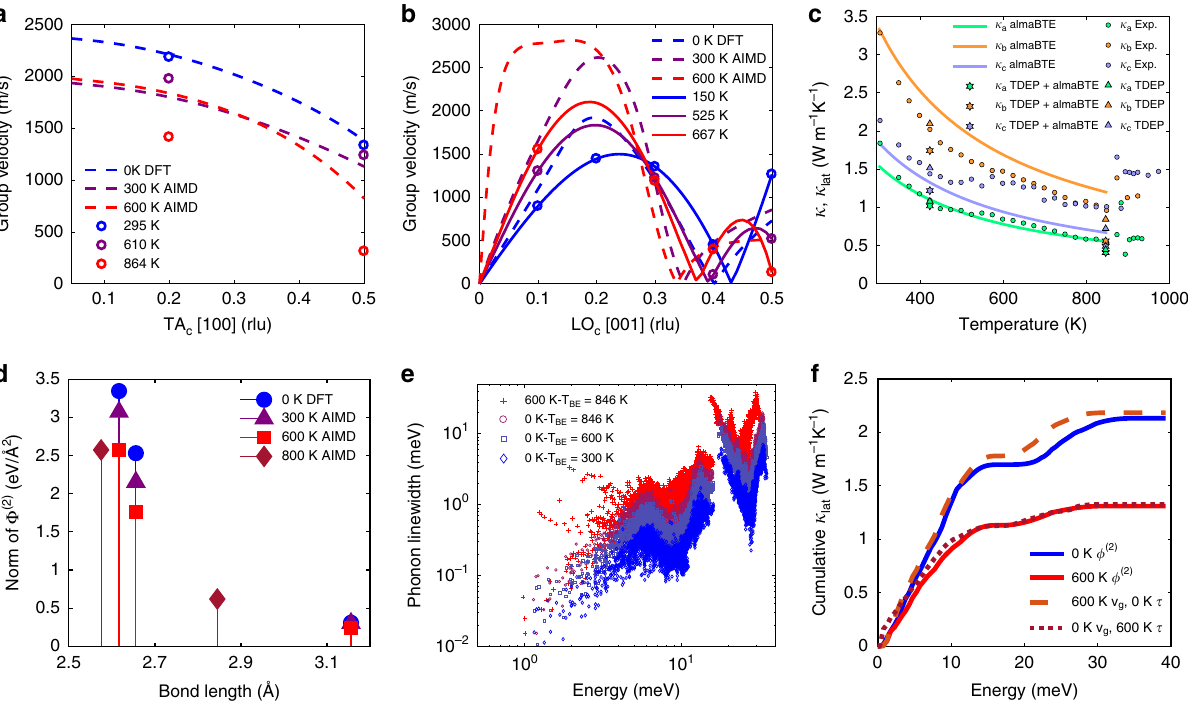
Fig. 4 Phonon renormalization and effect on thermal transport. a Group velocities extracted from experiments and simulations (see “ Methods ” for details) for the TA c along [100] (measured with CTAX at Q = (1.5, 0, 1) and (1.8,0,1)) and b LO c along [001]. Open circles show Q corresponding to experimental measurements, solid lines are for v g from experiments and dashed lines for v g from simulations. c Measured κ (circles) and calculated κ a , b , and c crystallographic directions. Lines represent κ lat (lines and markers) along the lat computed with almaBTE and triangles are values from TDEP, while stars are from almaBTE, but with renormalized Φ (2) from TDEP. d Norm of Φ (2) from DFT (0 K) and TDEP (Pnma at 300, 600 K and Cmcm at 800 K). e Phonon linewidths calculated with Φ (2) from 0 K DFT ( T BE = 300, 600 and 846 K) and 600 K TDEP ( T BE = 846 K) with fi xed Φ (3) (almaBTE). f Cumulative κ lat ( T BE = 300 K) from RTA with Φ (2) from 0 K DFT ( v g,0K + τ 0K ) and 600 K TDEP ( v g,600K + τ 600K ), as well as mixed group velocities and lifetimes ( v g,600K + τ 0K , and v g,0K + τ 600K ).